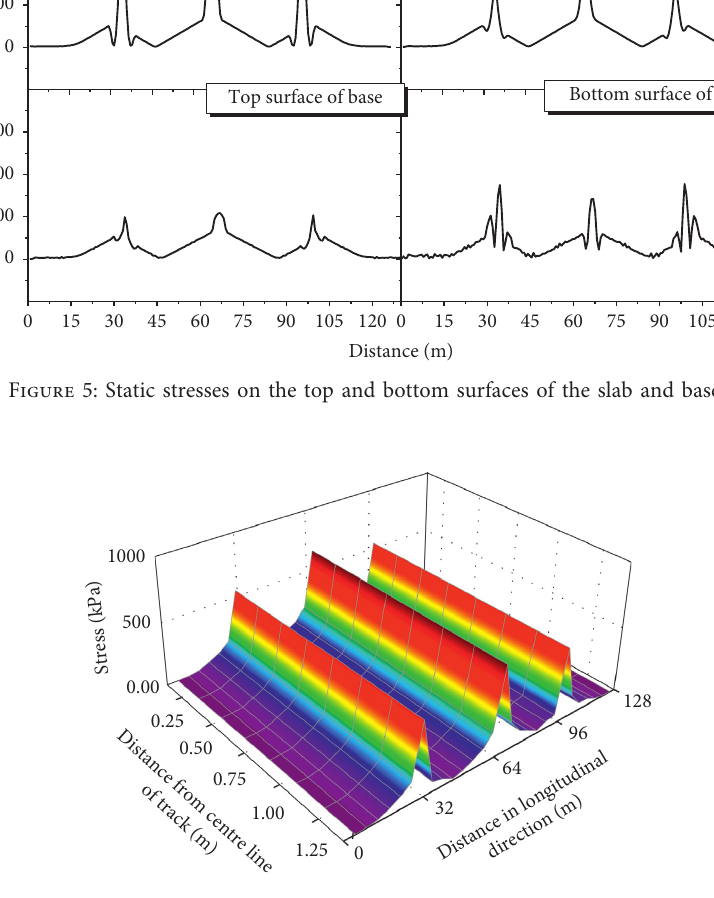
Figure 6: Spatial distribution of static additional stress on the top surface of